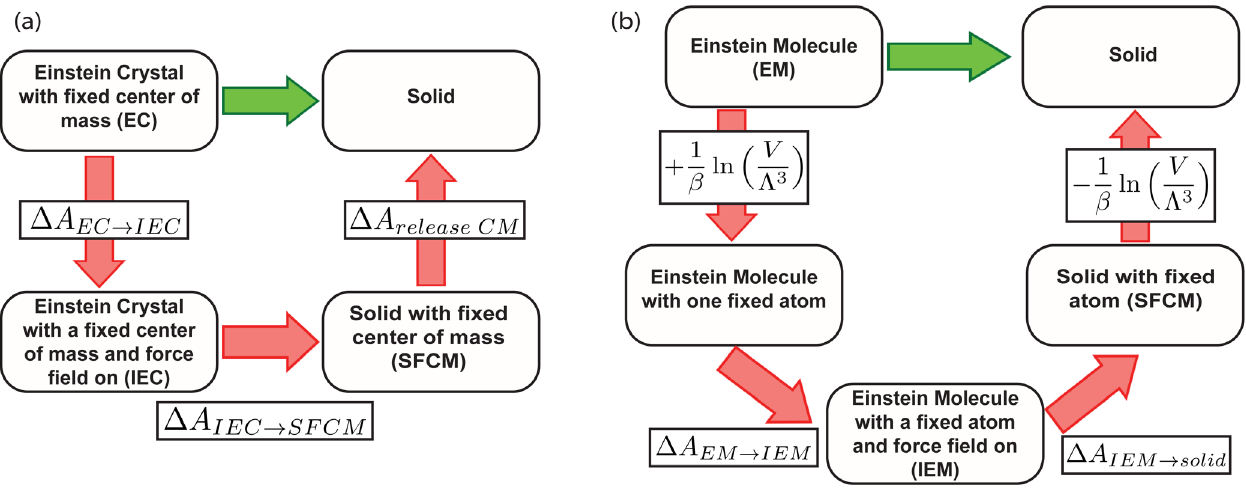
Figure 1. ( a ) Thermodynamic cycle representing the Einstein Crystal Method. ( b ) Thermodynamic cycle representing the Einstein molecule method (EMM). Note that the EMM requires only two free energy calculations despite being a bigger thermodynamic cycle. The canceling terms in ( b ) correspond to the free energies of fixing and releasing one atom in the crystal lattice 37